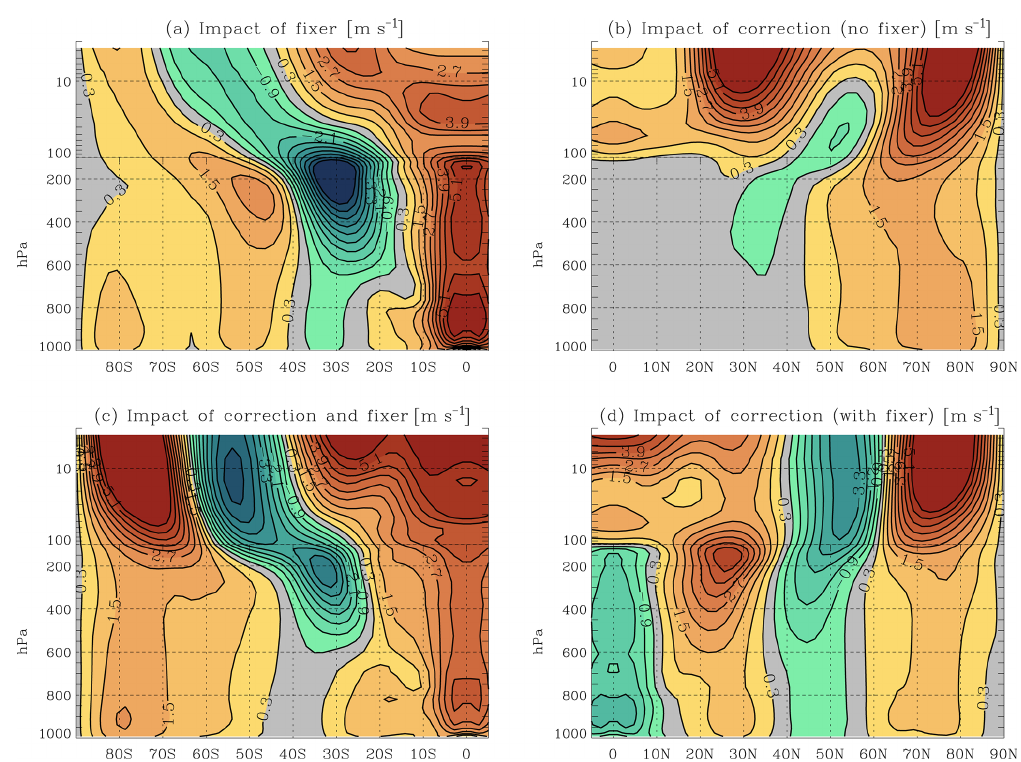
Figure 8. Impact of the AM correction and fixer in aquaplanet simulations. Same as Fig. 7, but for the AP simulations shown in the solid lines in Fig.